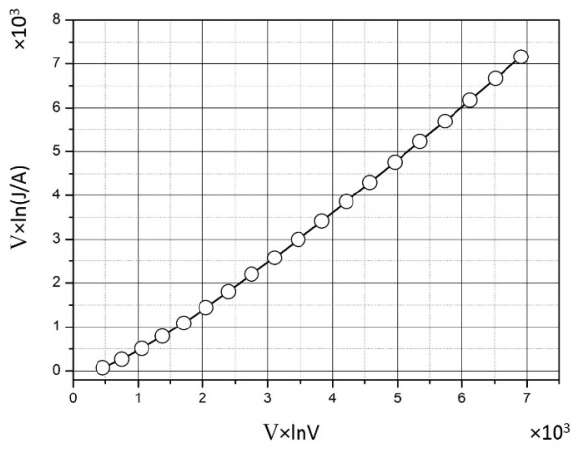
Figure 5. Current-voltage characteristic of a metal polymer based on a polyethylene matrix with iron nanoparticles (about 20 wt. %).